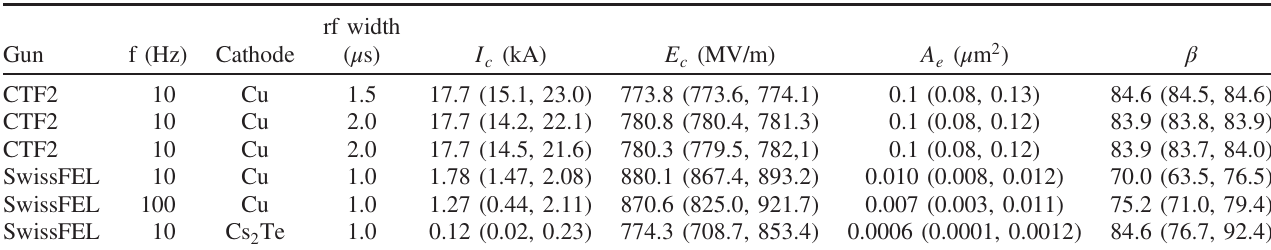
TABLE I. Parameters referring to the measurements shown in Fig. 10. I c and E c are fitting parameters with 95% confidence bounds also indicated in parenthesis. A e and β are the emitter area and the field enhancement factor with 95% confidence bounds indicated in